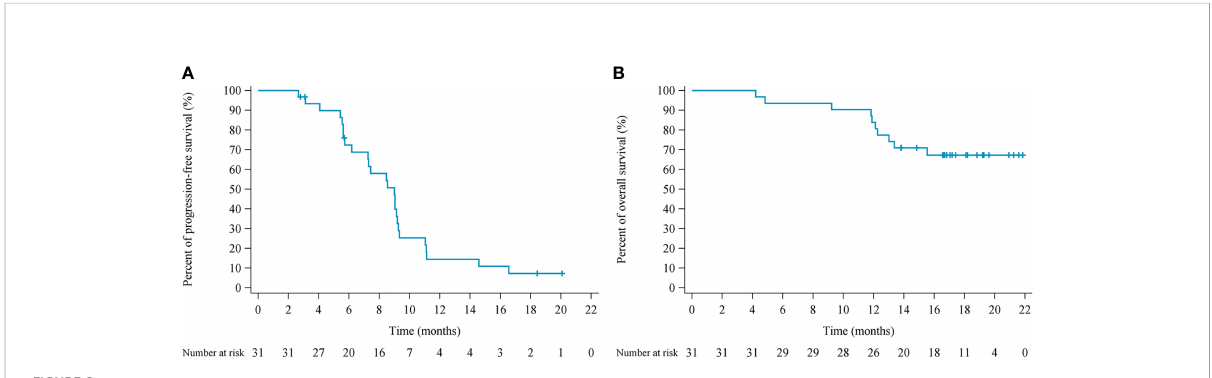
FIGURE 2 Kaplan – Meier estimates of progression-free survival (A) and overall survival (B)